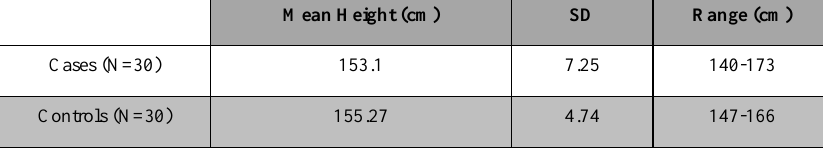
Table 3. Height distribution of study subjects among case and control groups.